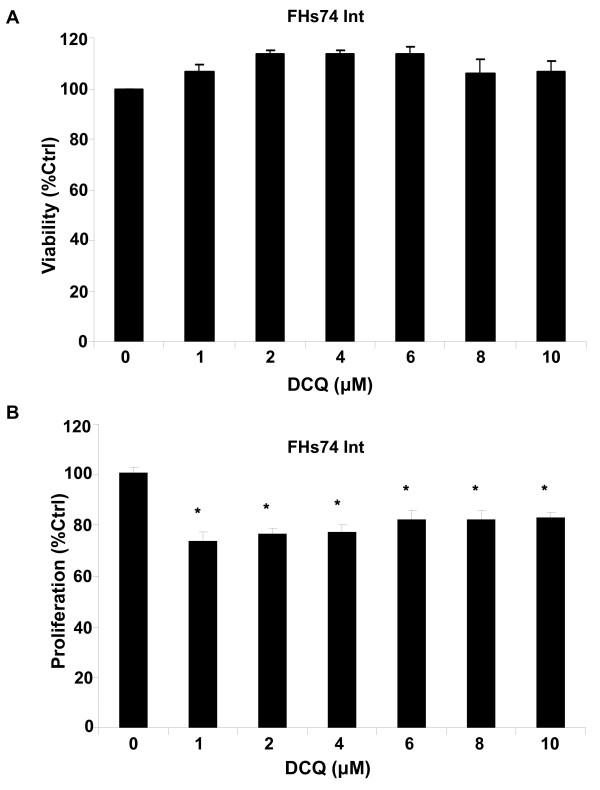
DCQ is not cytotoxic to normal intestinal cells. DCQ at concentrations of up to 10 μM did not reduce FHs74 Int human normal intestinal cell viability. At 50% confluency, cells were exposed to DCQ for 6 hr or were left untreated. Viability was assessed by the Cytotox 96 non-radioactive assay (A) and by the MTT-based Promega assay (B). Values are averages ± SE of two independent experiments each done in triplicates. The experiment was repeated three times each in triplicates.